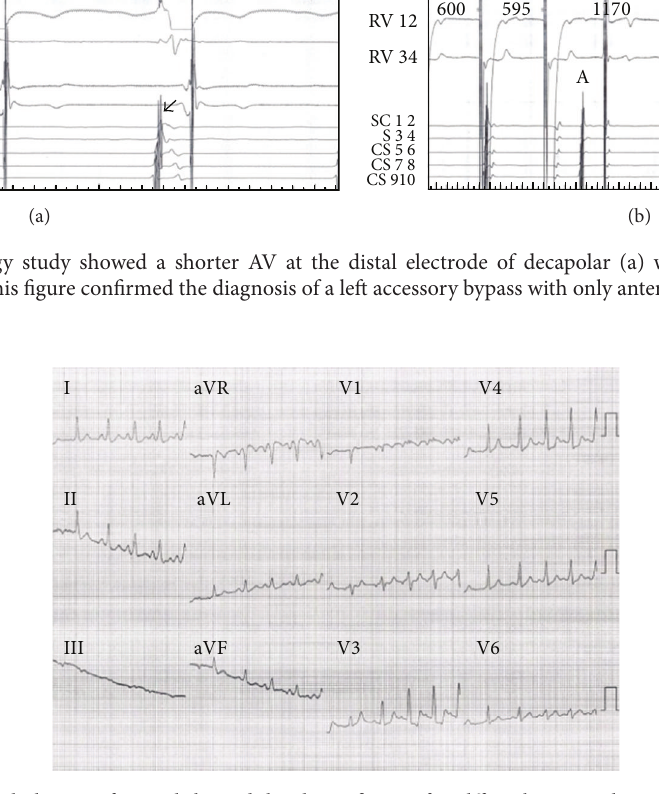
Figure 4: ECG after using isuprel: the use of isuprel showed the classic figure of Wolff-Parkinson-White syndrome with a typical QRS with slurred initial